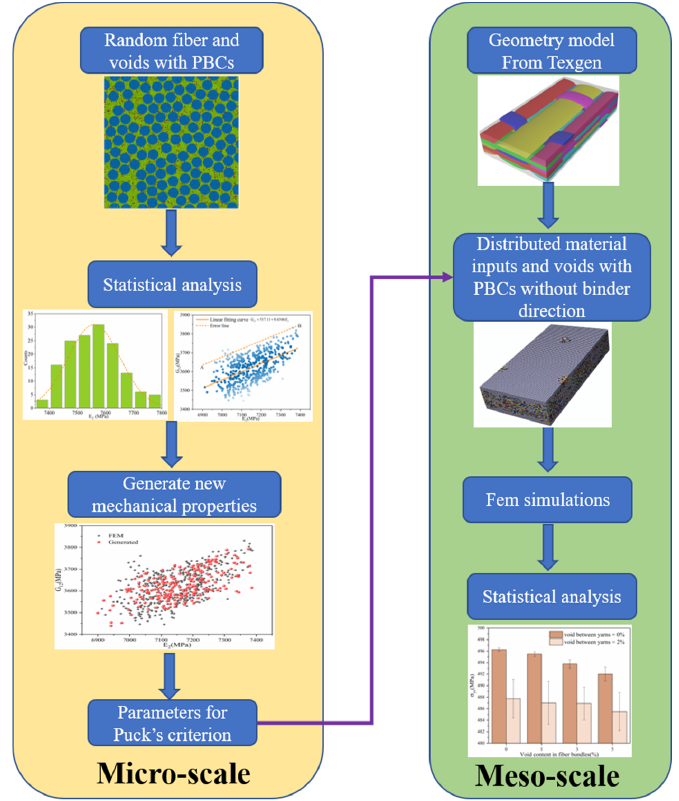
Figure 1. Multiscale stochastic modeling framework. Table 1. Mechanical properties of fiber and matrix.